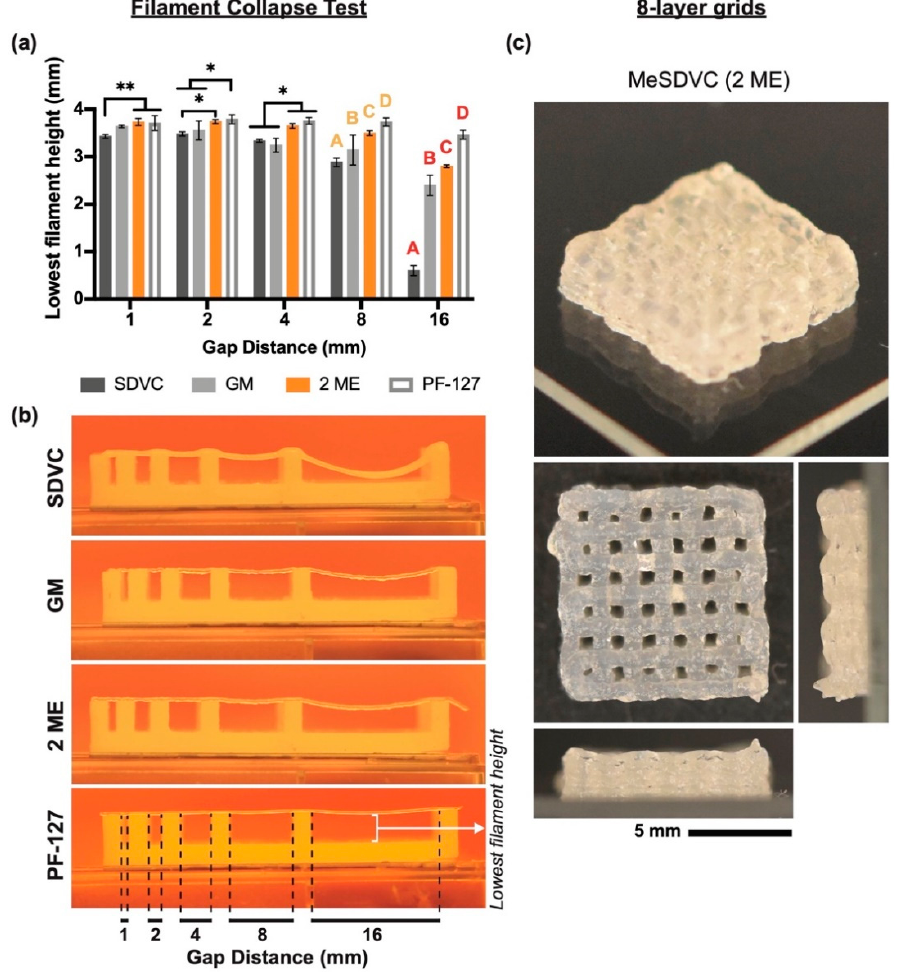
Figure 6. The 2 ME MA MeSDVC had the best printability and ability to print taller structures. ( a , b ) The filament collapse test consisted of material precursors being printed over gaps of different sizes (i.e., 1, 2, 4, 8, and 16 mm) and modified analyses were performed, where the lowest filament height between the gaps was measured (n = 3–6). The 2 ME MA MeSDVC and the GM MeSDVC were tested, given that the 5 ME and 10 ME were not able to complete the test due to nozzle clogging. SDVC and PF-127 were included as comparators. Overall, the 2 ME MA MeSDVC precursor was able to span larger gaps with less collapse than the GM MeSDVC precursor and SDVC. ( c ) The 2 ME MA MeSDVC precursor was printed in an eight-layer grid to show the ability to print taller scaffolds without good shape fidelity and without collapse. * p < 0.05. ** p < 0.01. Letters indicate significance from other letters of the same color ( p < 0.05). Scale bar: 5 mm.